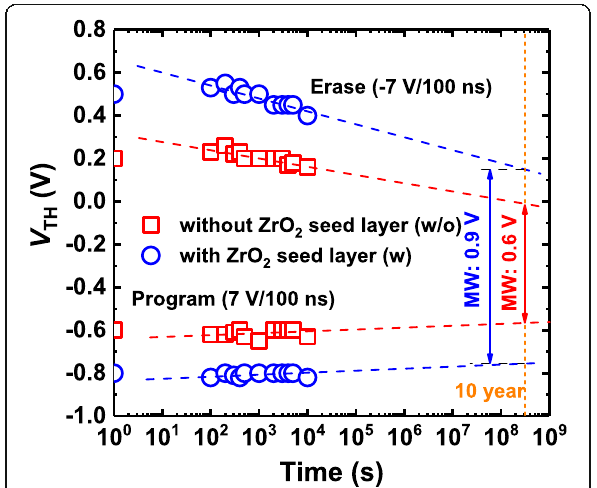
Fig. 3 Retention characteristics of HZO-based FeFETs with and without ZrO 2 seed